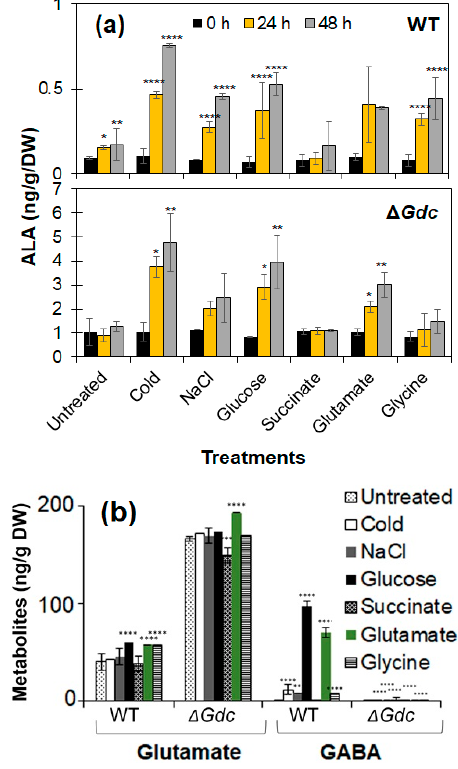
Figure 4. Analysis of the metabolite alteration in Synechocystis strains under various treatments. ( a ) δ -Aminolevulinic acid (ALA) and ( b ) relevant metabolite (glutamate and GABA) levels in wild- type (WT) and ∆ Gdc strains of Synechocystis , after using the BG11 medium as a control (untreated). Results represent the mean ± standard deviation (SD) of experiments conducted in triplicate ( n = 3). The differences between means of the individual groups were analysed using one-way analysis of variance (ANOVA) via GraphPad Prism 9.3.1 software (San Diego, CA, USA). In ( a ), * p < 0.05, ** p < 0.01, **** p < 0.001 versus 0 h, and in ( b ), *** p < 0.005, **** p < 0.001 versus untreated